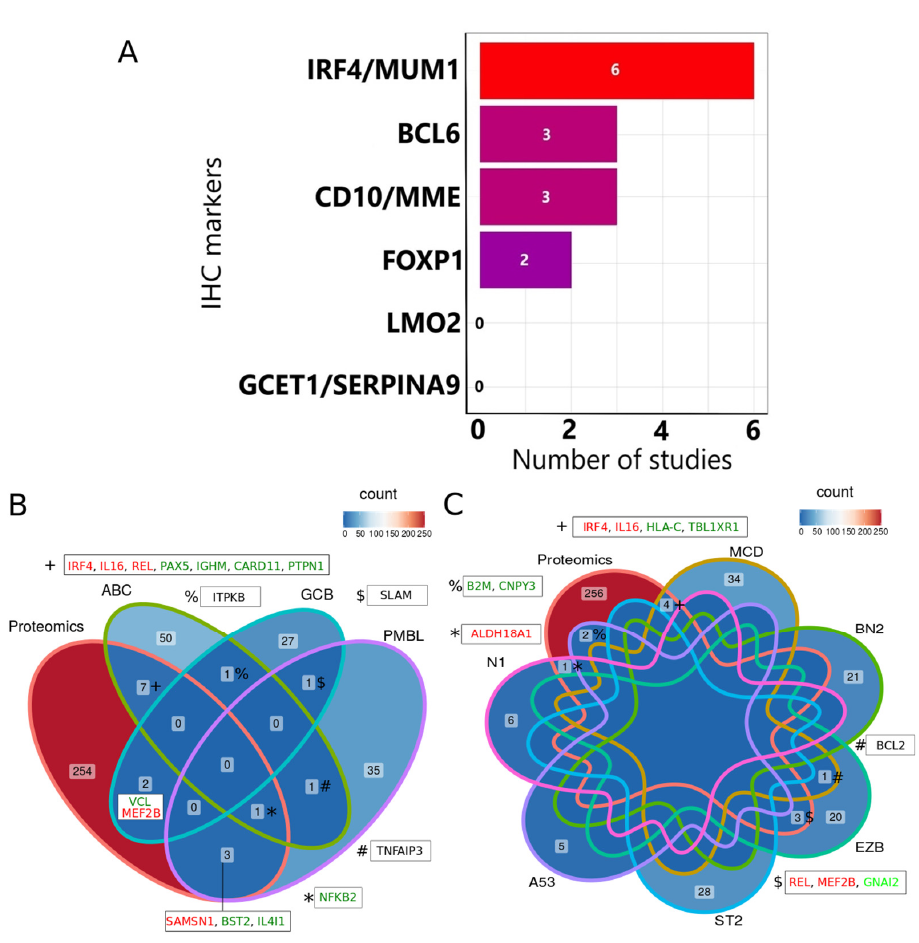
Figure 2. An overview of common proteins/genes between IHC, genomics and proteomics. ( A ) The number of times IHC markers were reported in the 27 reviewed articles. ( B ) Common gene overlap between the current study and genome-wide studies. ( C ) Common genes between the LymphGen algorithm and proteomics. The colors in the Venn diagrams indicate the number of genes in each area. Red and blue represent the area with the highest and lowest number of genes, respectively. In ( B , C ) up- and down-regulated proteins common between proteomics studies, genome-based studies, and the LymphGen algorithm are indicated with green and red letters, respectively. Genes mutated in multiple subtypes but not identified as regulated in proteomics studies are indicated with black letters. The symbols “* $ * # % + ” links Venn sub group with the indicated gene names.